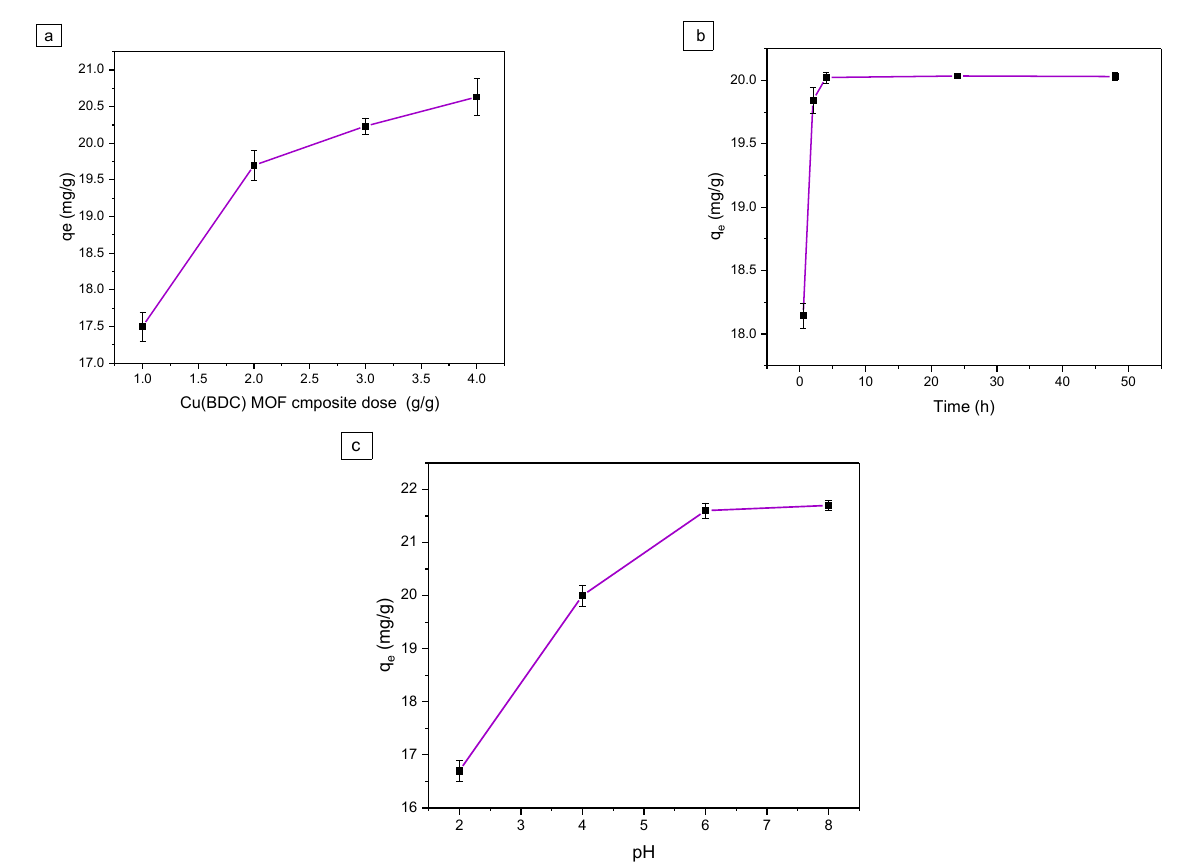
Figure 2. The effect of: ( a ) the adsorbent dose on the adsorption process at a temperature of 298 K, pH 4.0, and initial TPC of 440 mg/L; ( b ) the equilibrium time of the adsorption process at a temperature of 298 K, pH 4.0, 2% by weight adsorbent dose, and ( c ) the OMW pH on the TPC uptake using 2% by weight adsorbent dose, 440 mg/L initial TPC concentration, at a temperature of 298 K, and a contact time of 4 h.